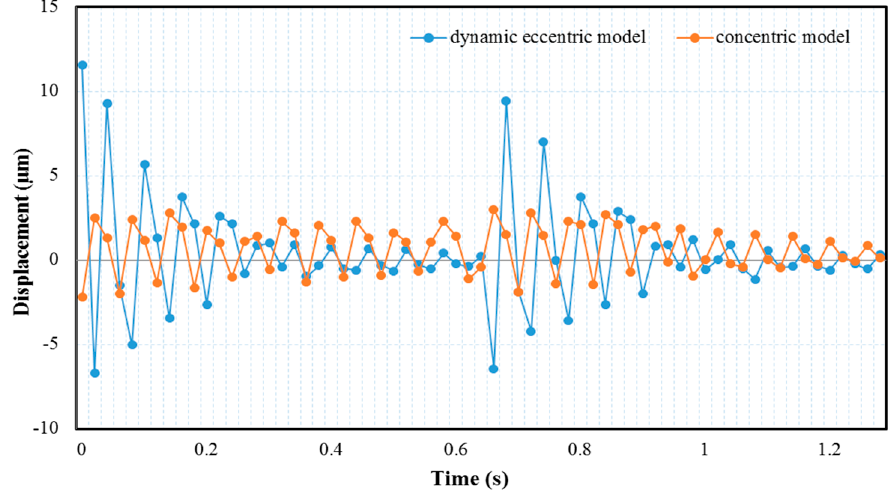
Figure 15. Comparison between concentric model and dynamic eccentric model.